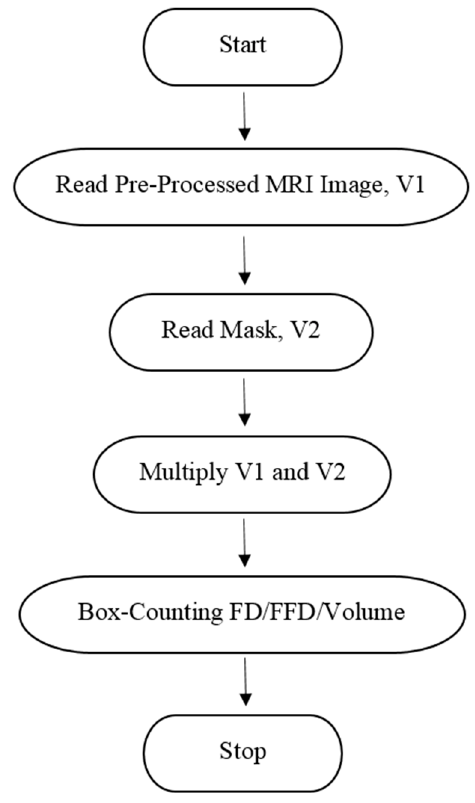
Figure 4. The flowchart of VOI-based analysis with masking.